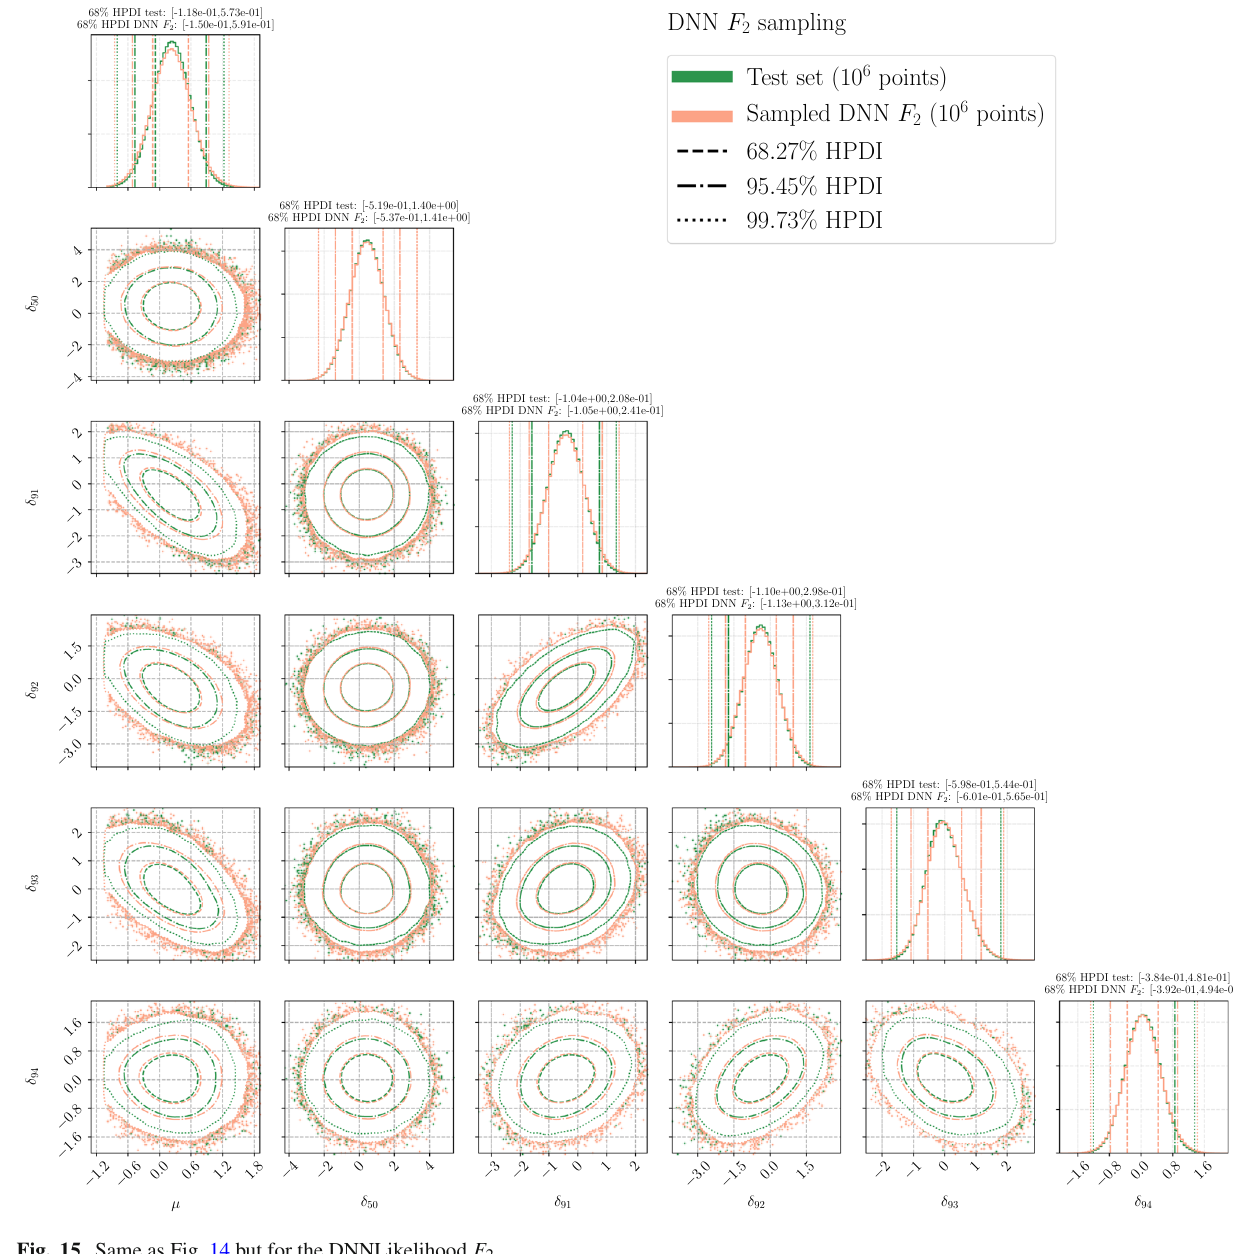
Fig. 15 Same as Fig. 14 but for the DNNLikelihood F 2 Table 5 HPDI obtained from the different DNNLikelihood models F 1 − F 3 both by reweighting on the test set of S 1 (upper block) and by re-sampling (lower block). Results are only shown as upper bound on μ